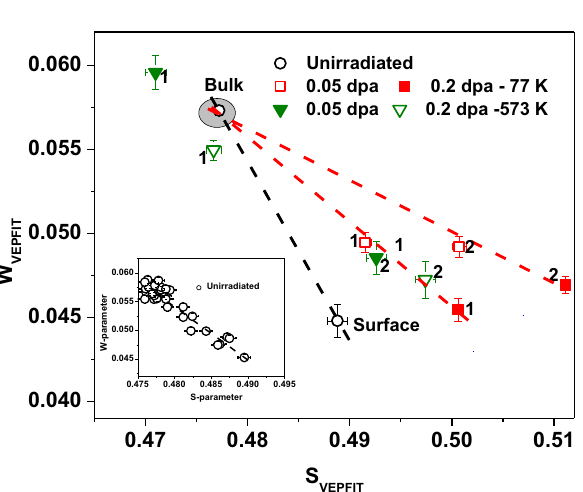
Figure 11. S-W correlation of unirradiated and irradiated samples corresponding to two different regions evaluated using VEPFIT. The inset shows the S-W correlation of unirradiated sample using experimental S- and W-parameters. Label 1 and 2 represent the 1 st and 2 nd layer starting from the surface for the fitting the S-E profiles using VEPFIT (see Table